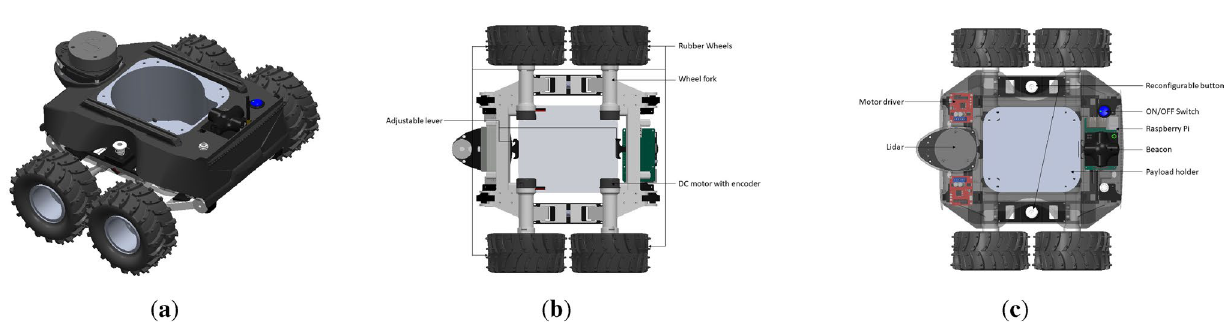
Figure 3. Raptor mechanical